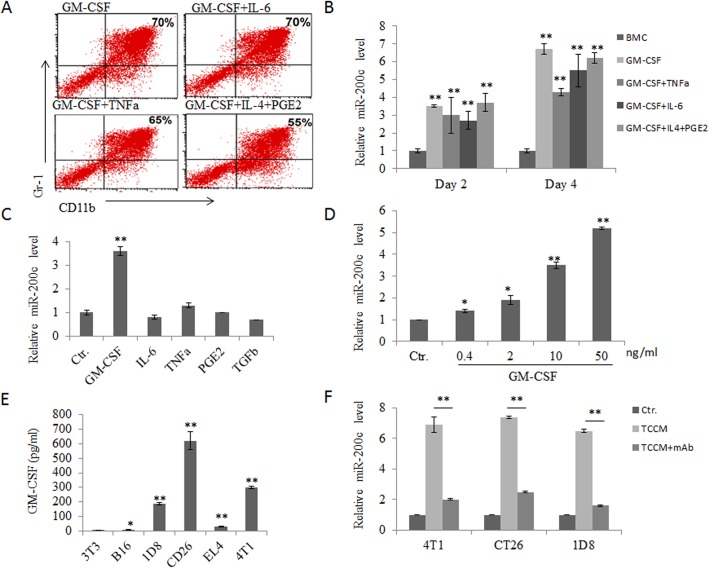
MiR-200c is upregulated by tumor associated GM-CSF.(A) Generation of BM cells derived CD11b+Gr1+ cells. BM cells derived CD11b+Gr1+ cells were generated by culturing with GM-CSF (40 ng/ml) or GM-CSF (40 ng/ml) with IL-6 (40 ng/ml), TNFα (40 ng/ml), or IL-4 (40 ng/ml) plus PGE2 (1.0 μg/ml). The proportion of Gr-1+CD11b+ cells was analyzed by FAScan. (B) Expression of miR-200c in differently derived MDSCs. BM cells derived CD11b+Gr1+ cells were generated by culturing with GM-CSF or GM-CSF with IL-6, TNFα, or IL-4 plus PGE2. Total RNAs were isolated from either fresh (fresh) or MDSCs (days 2 or 4 after exposed to the simulators) and miR-200c content was detected by qRT-PCR. Data are normalized to miRNA level in fresh BM cells. (C) Expression of miR-200c in different cytokines treated BM cells. BM cells were treated with different tumor-derived factors GM-CSF, IL-6, TNFα, PGE2 or TGFβ. Ctr., no tumor-derived factor. MiR-200c expression was examined after 24 h. (D) Expression of miR-200c in different doses of GM-CSF treated MDSC. BM cells were cultured with different concentrations of GM-CSF and then expression of miR-200c was analyzed. (E) GM-CSF levels in the supernatants of different tumor cell lines. The tumor supernatants were collected and analyzed by ELISA. (F) Effects of anti-GM-CSF on the expression of miR-200c. BM cells were cultured with 4T1, CT-26 or ID8 TCCM (25% v/v), without or with 10 μg/ml anti-GM-CSF Ab for 36 h. MiR-200c transcriptional levels were detected by qRT-PCR. Ctr., only medium; TCCM, medium with 25% tumor supernatants; TCCM+mAb, medium with 25% tumor supernatants plus anti-murine GM-CSF antibodies. Data are a representative of three independent experiments. *, p<0.05; **, P<0.01.